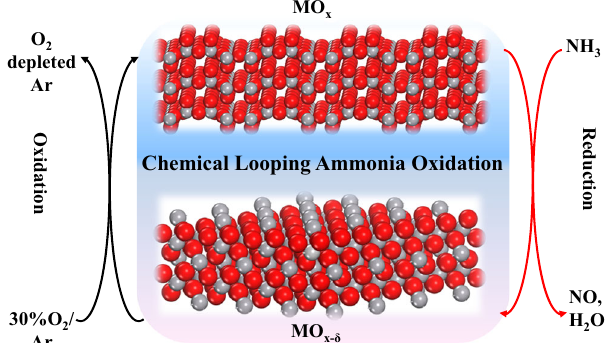
Fig. 1 Schematic of the chemical looping ammonia oxidation (CLAO) process. The red and gray spheres represent metal and oxygen atoms,